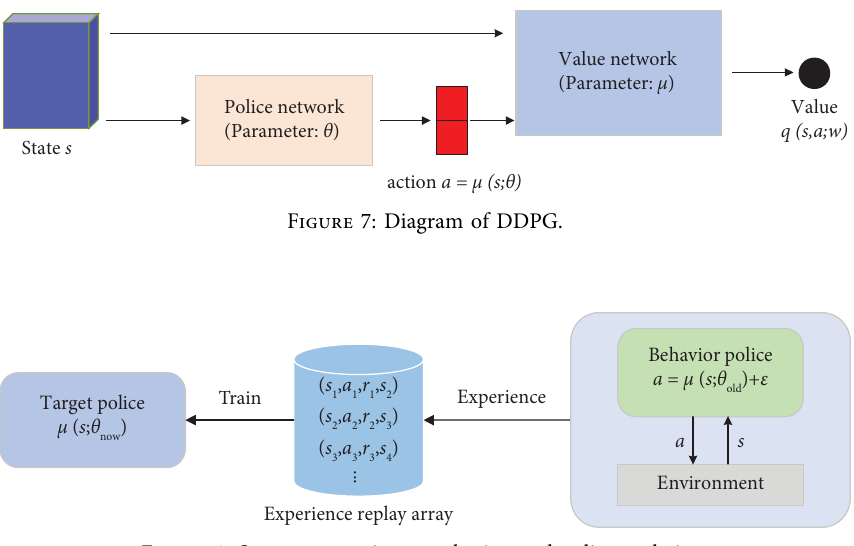
Figure 8: Separate experience gathering and policy